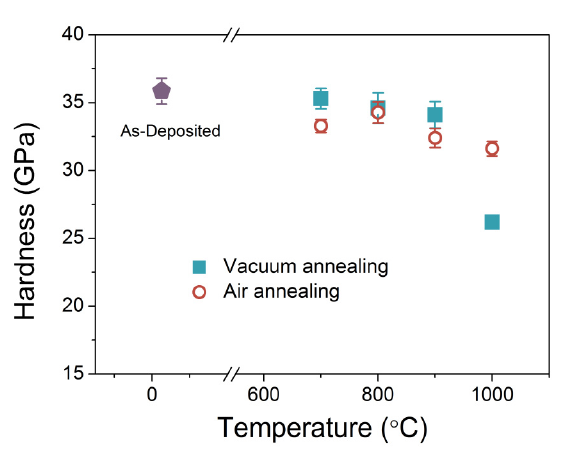
Figure 2. Hardness values of as-deposited and air/vacuum-annealed (Al 0.34 Cr 0.22 Nb 0.11 Si 0.11 Ti 0.22 ) 50 N 50 coatings.